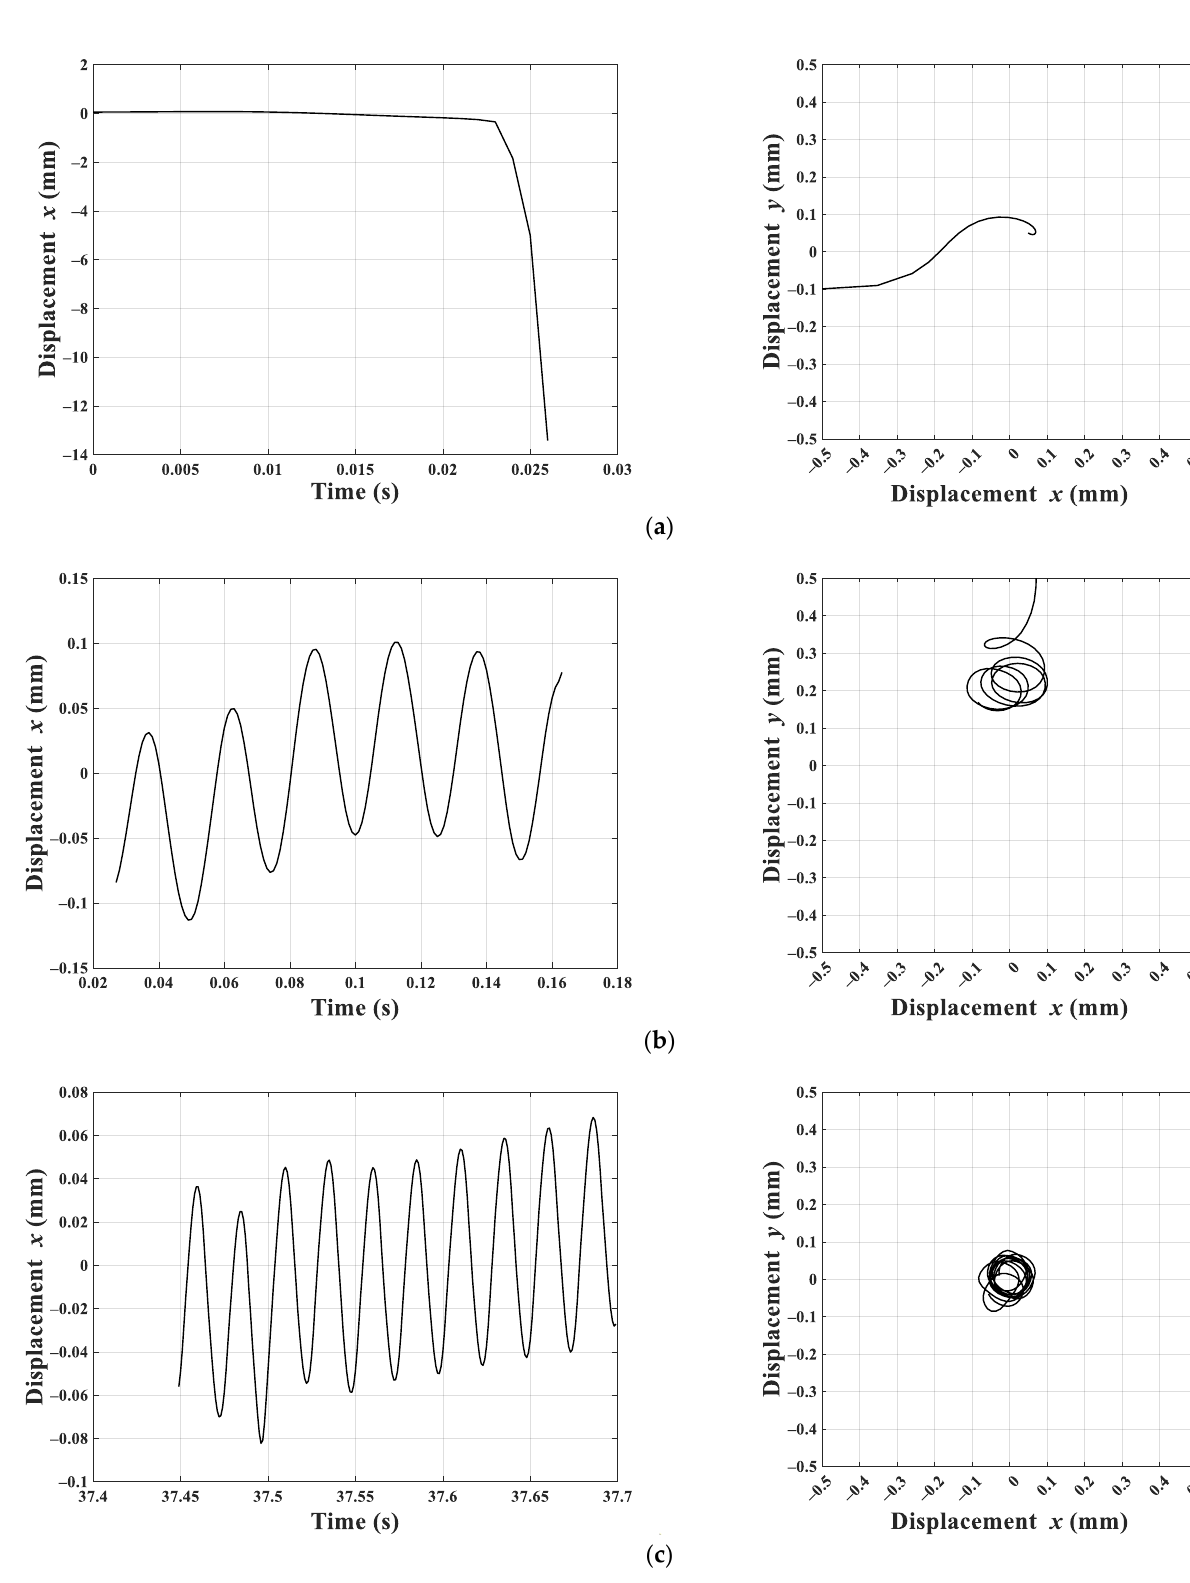
= 250 rad/s, 05.0 00 == yx y ) for 0